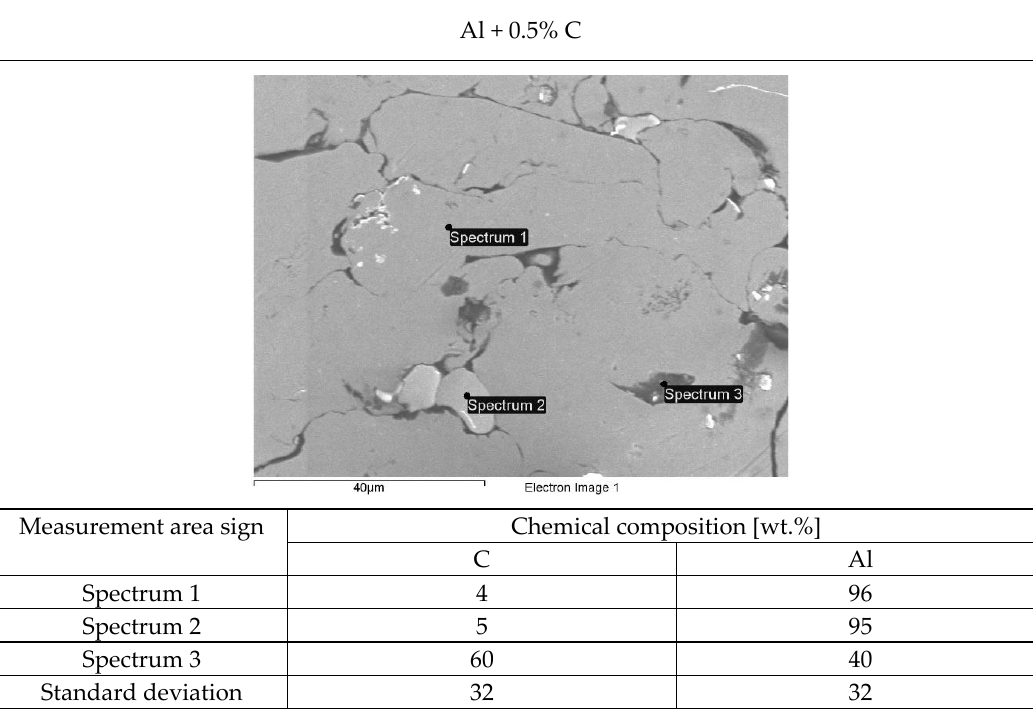
Figure 9 . The structure of aluminum powder with 0.5 wt.% carburite carbon nanotubes flame-sprayed coating with marked chemical composition tested areas on SEM .